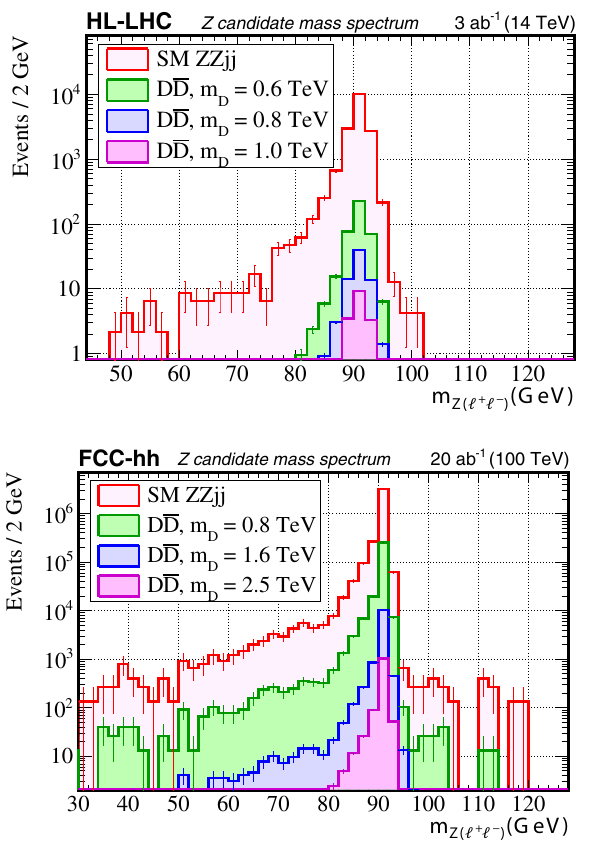
Fig. 4 Transversemomentumdistributionforbothjetsusedin D quark reconstruction for HL-LHC (top) and FCC-hh (bottom) conditions. The jets are selected by minimizing the condition defined in Eq.